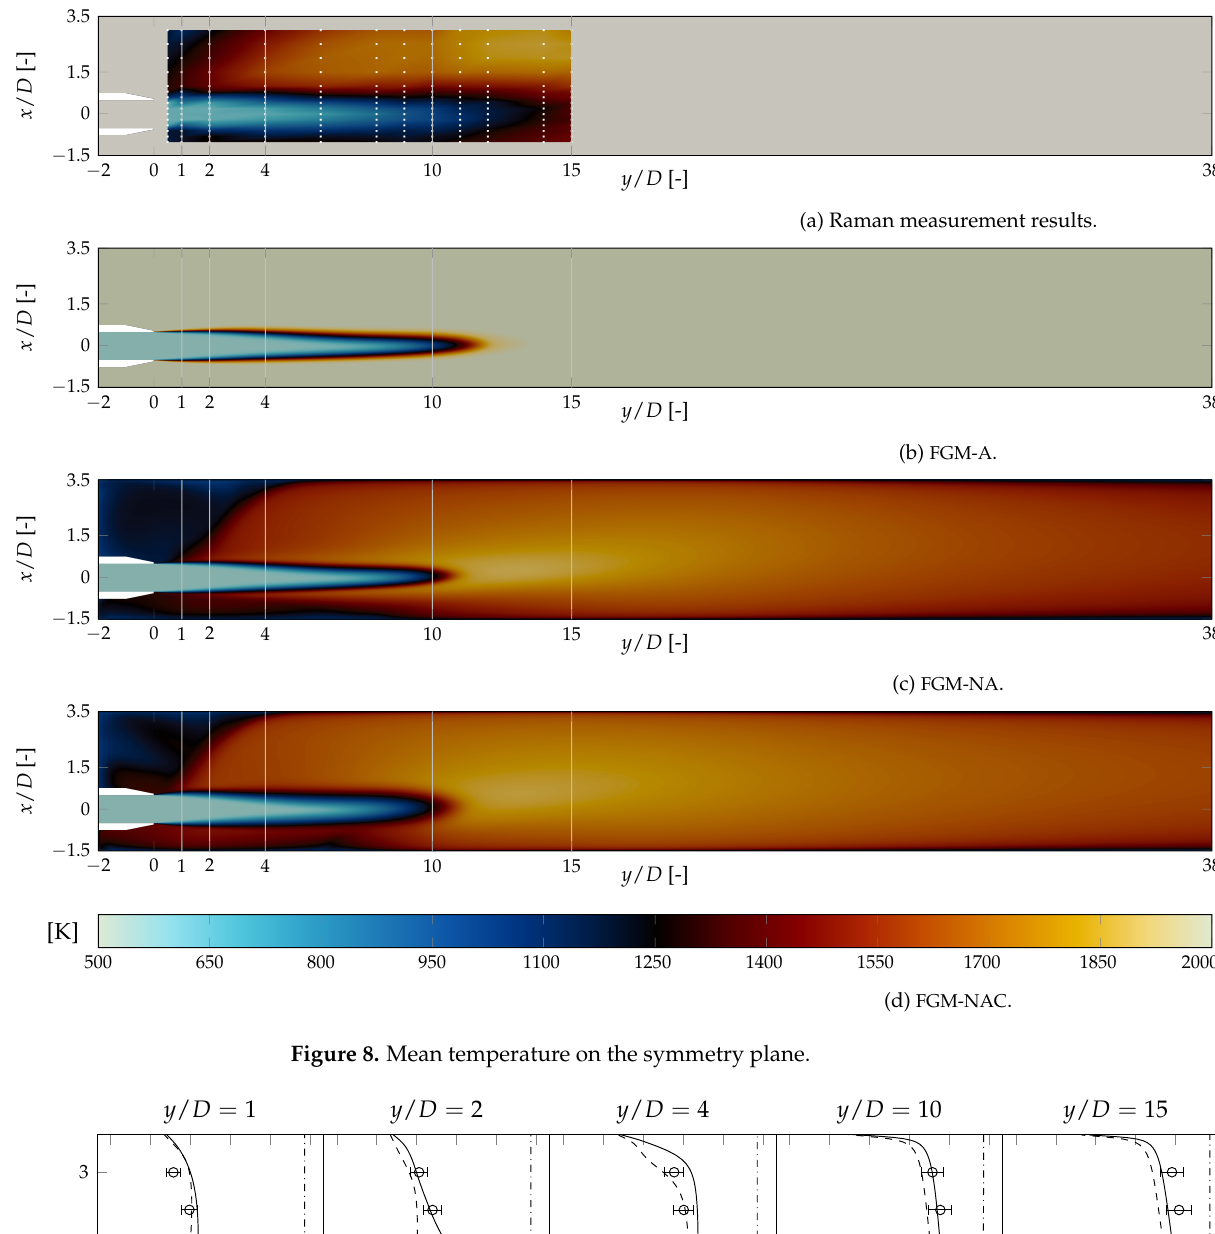
The temperature profile plots also show the effect of the velocity-pressure coupling 284